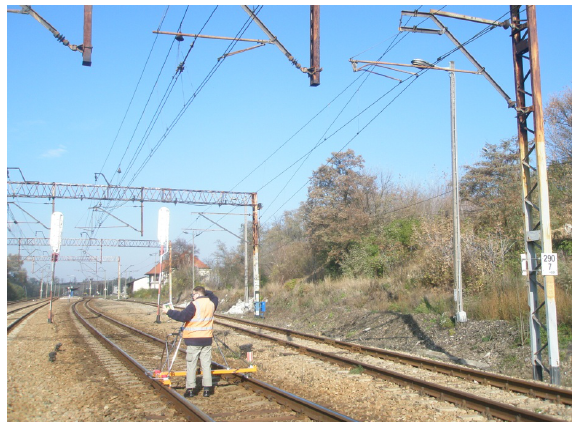
Figure 6. Cross section through the railway station at S ł omniki, obtained with System